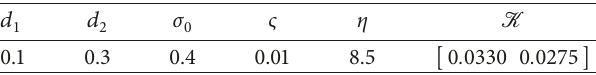
, d , η , ς , and σ in 1 2 0